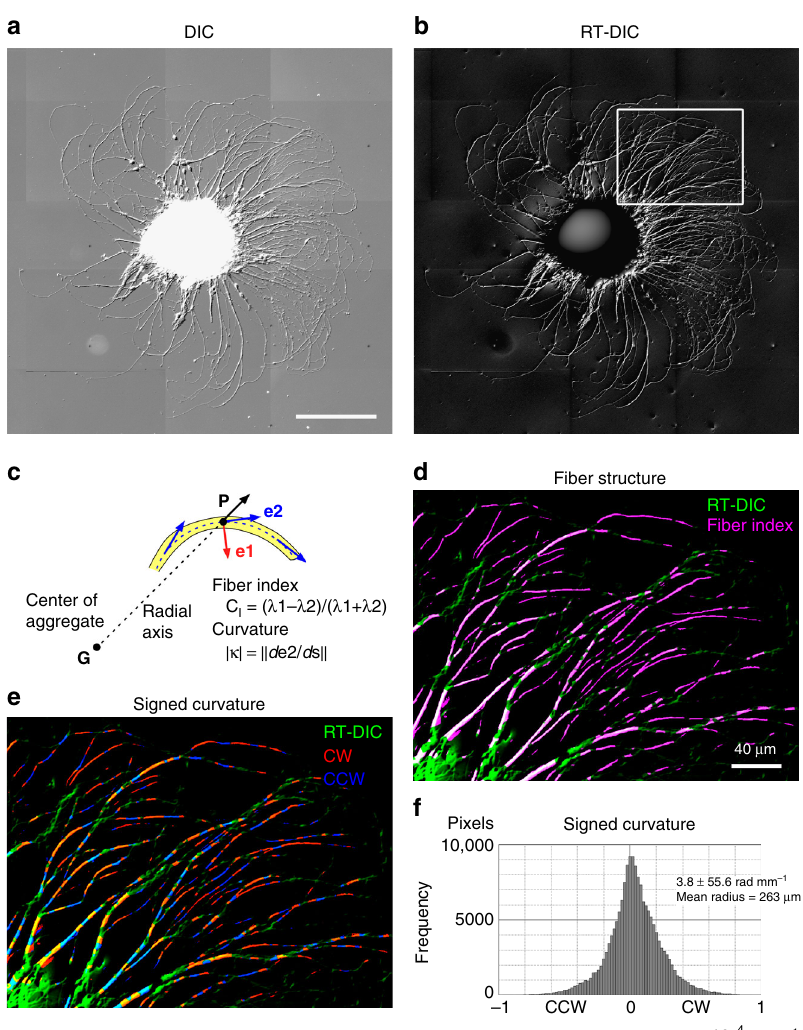
Fig. 5 Quanti fi cation of chirality in the clockwise neurite growth on 2D surface. a A montaged still DIC image of a hippocampal neuronal re-aggregate cultured for 48 h. Neurites extended from the re-aggregate turned clockwise as previously reported 5,6 . b RT-DIC image of a . Neurites appear as self- luminous objects. c Feature estimation with the structure tensor. Neurites are extracted by the eigenvalue-derived fi ber index. The curvature of a neurite is calculated as a differential of e2 along the arc formed by e2 . The curvature is signed by the radial axis. d Neurite fragments extracted by the fi ber index. Only the rectangular region in b is shown. e Distribution of signed curvature on the extracted neurite fragments. Positive (red) and negative (blue) values represent clockwise (CW) and counterclockwise (CCW) rotation, respectively. f Histogram of the signed curvature. The values represent mean ± s.d. ( n = 1.7 × 10 5 pixels). P < 0.0001 by Wilcoxon signed-rank test against zero. Scale bars, 200 μ m in a for a and b , 40 μ m in d for d and